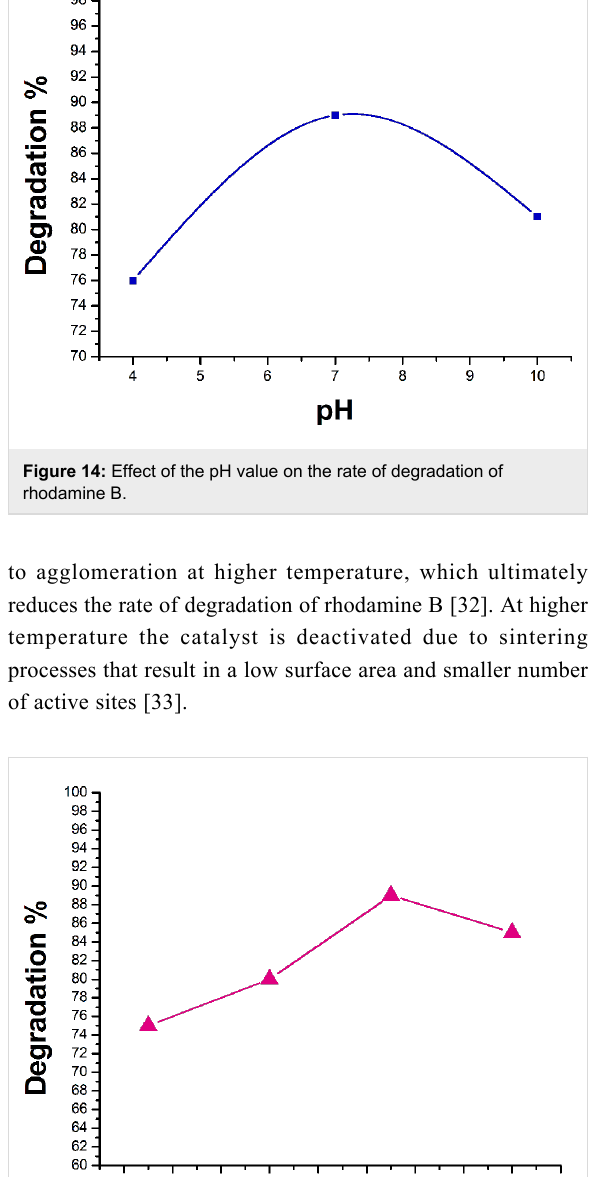
Figure 15: Effect of the calcination temperature on the rate of degrad- ation of rhodamine